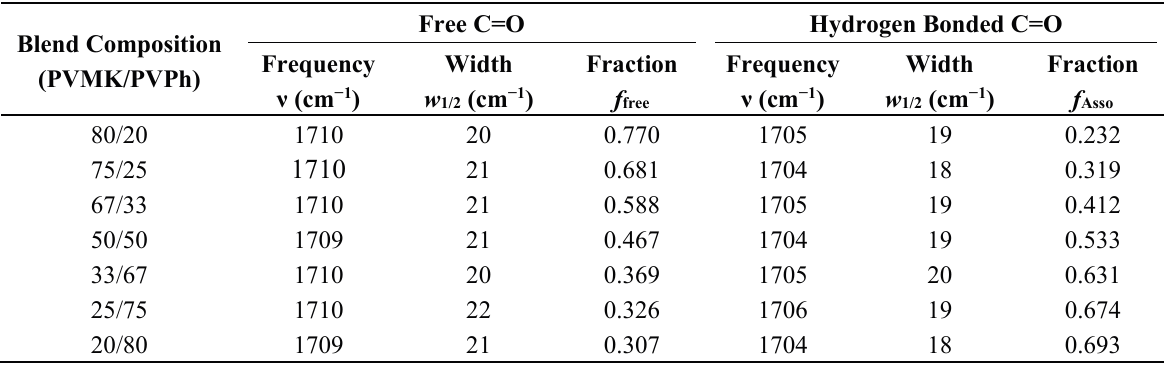
Data obtained by fixing the positions and widths at half-height ( ν , w 1/2 cm − 1 ) of free carbonyl (1710 and 21, respectively) in the 1780–1650 cm − 1 region.